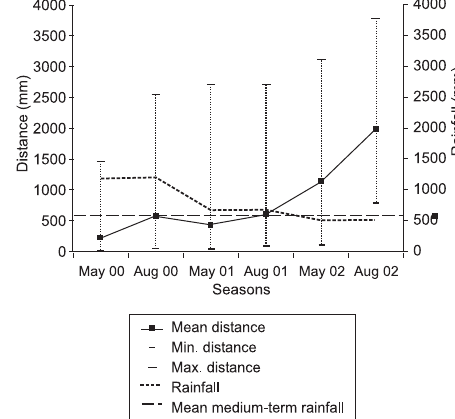
Fig. 6. Descriptive relationship of distances between water source sites and seasonal rainfall in the Manyeleti Game Reserve.